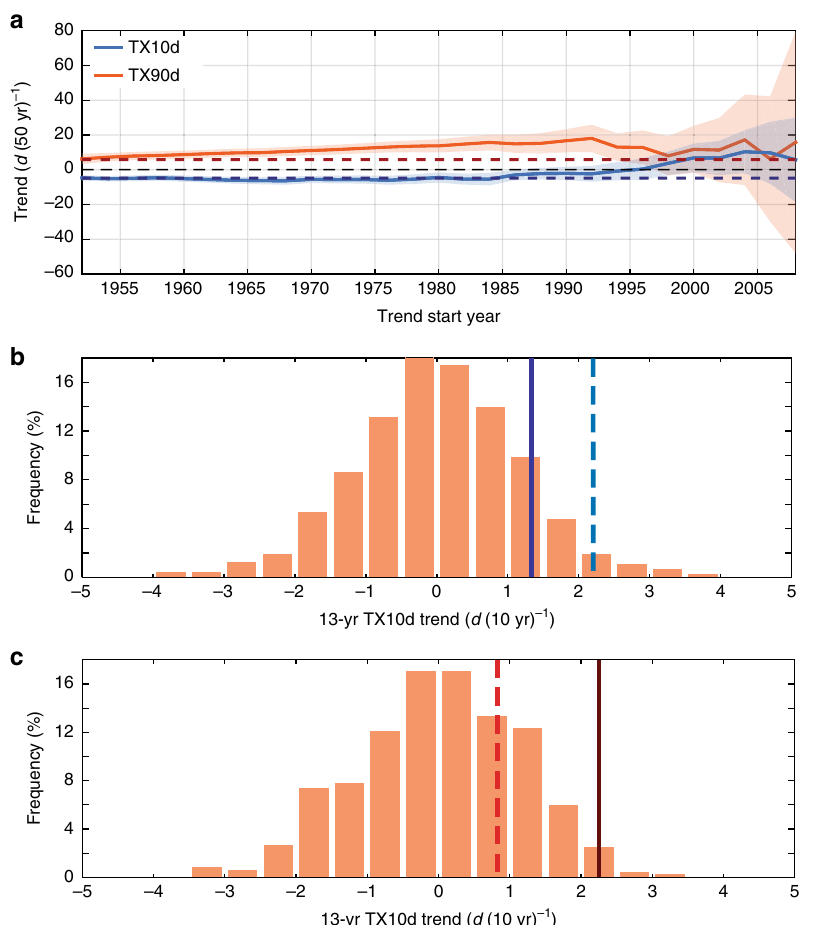
Fig. 4 Internal variability of Northern Hemisphere wintertime cold and summertime warm extreme occurrences. a Linear trends ( d [50 yr] − 1 ) of DJFM TX10d (blue) and JJAS TX90d (orange) with variable starting years (x-axis) and an end year of 2014. Shading indicates the 95% con fi dence interval. The dashed blue (red) line indicates the full 1951 – 2014 linear trend for DJFM TX10d (JJAS TX90d). b Histogram of the 13-yr DJFM TX10d trends in the 500-yr FLOR simulation. The dark blue line is the observed value based on HadEX2 combined with ERA-Interim data for the 2002 – 2014 period. The dashed blue line is the observed value for the 2002 – 2014 period after the removal of the 1951 – 2014 linear trend. c Same as b but for the 13-yr JJAS TX90d trends. The dark red line is the observed value for the period 2002 – 2014, and the dashed red line is the observed value after the removal of the 1951 – 2014 linear